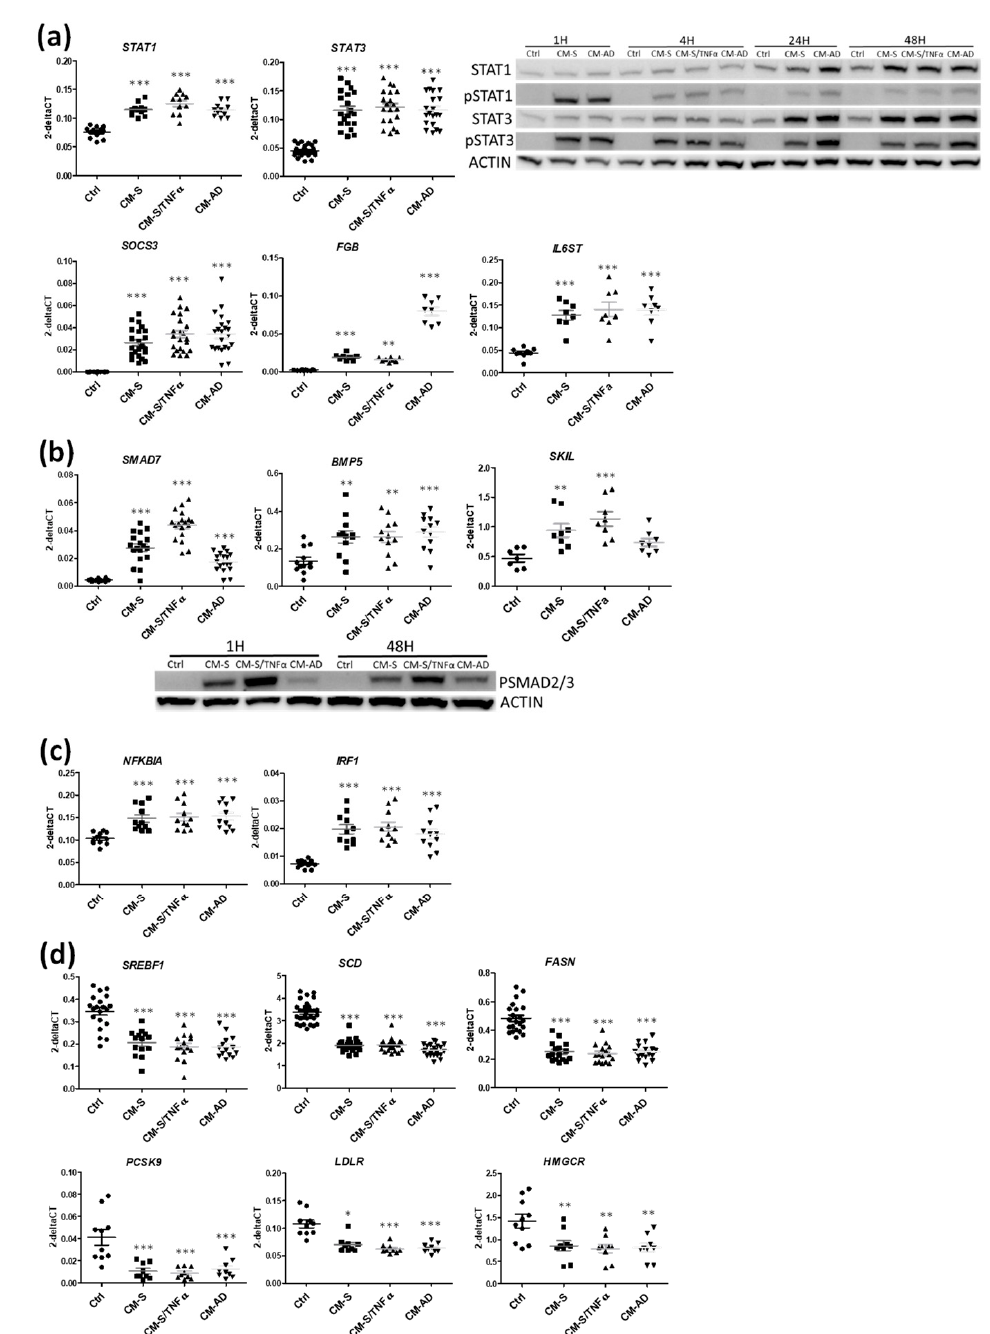
Figure 2. Effects of CM from omental adipose stromal cells on the STAT, SMAD and NFKB pathways and on lipogenesis and cholesterol synthesis genes in EndoC- β H1 cells. EndoC- β H1 cells were exposed to CMs. ( a ) Genes linked to the STAT pathway were analyzed by RT-qPCR after 48 h of treatment (n = 8–22). STAT1, pSTAT1, STAT3 and pSTAT3 were analyzed by Western blot after 1, 4, 24 and 48 h of treatment (n = 5). ( b ) Genes linked to the SMAD pathway were analyzed by RT-qPCR after 48 h of treatment (n = 8–18). PSMAD2/3 was analyzed by Western blot after 1 and 48 h of treatment (n = 6). ( c , d ) Genes linked to the NFKB pathway and to lipogenesis and cholesterol synthesis were analyzed by RT-qPCR after 48 h of treatment (n = 9–24). Data are represented as mean ± SD. * p < 0.05, ** p < 0.01, *** p <